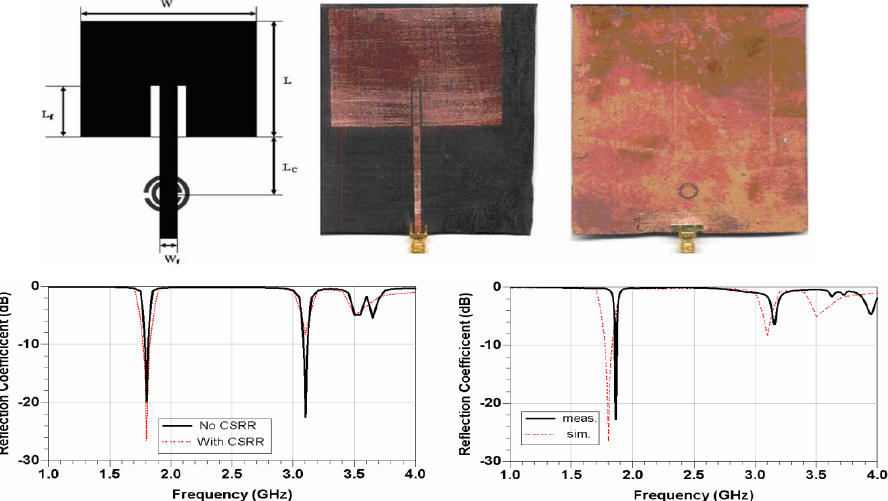
Figure 8. Return loss comparison of CSRR-loaded antenna proposed in [79], representing the size reduction of the antenna. Reprinted from Ref. [79].